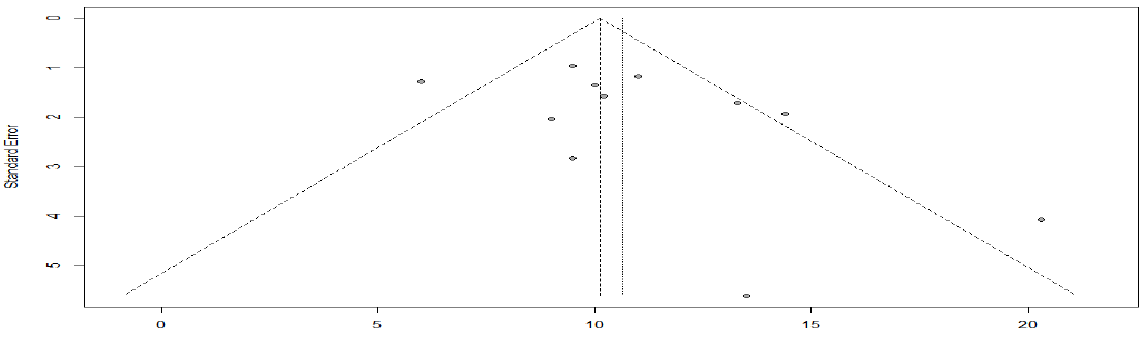
Figure 5. Funnel plot of overall survival with targeted therapy.